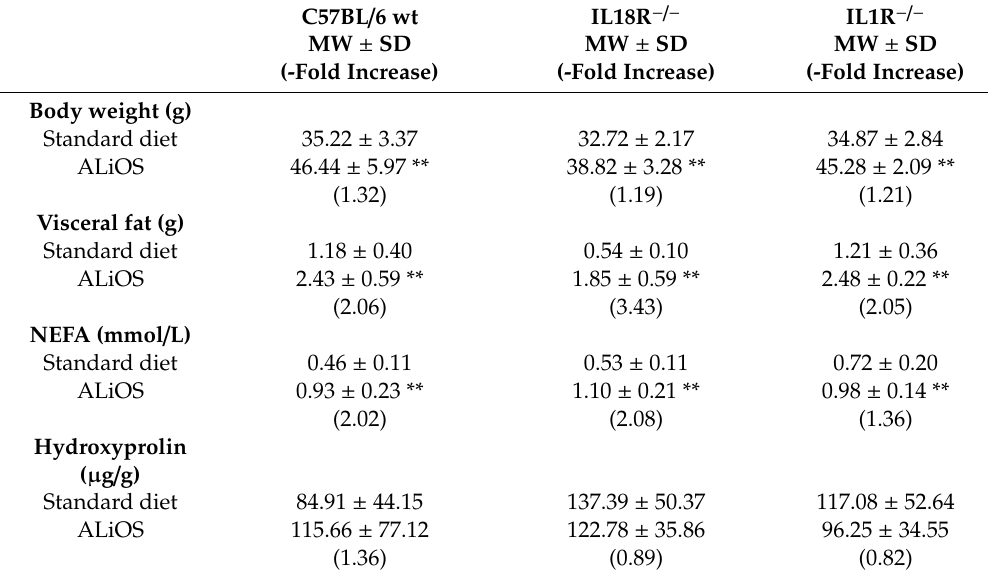
Table 2. E ff ect of genotype on body composition, serum fatty acids and liver fibrosis. Wildtype mice were fed standard diet or ALiOS diet for 24 weeks. Total values (mean ± standard deviation) and fold increase are given for body weight, visceral fat, non-esterized fatty acids (NEFA) in serum and hydroxyproline in liver tissue ( n = 14 for wildtype, n = 8 for IL-18R − / − , n = 10 for IL-1R − / − ; ** p < 0.01 compared to standard diet, t